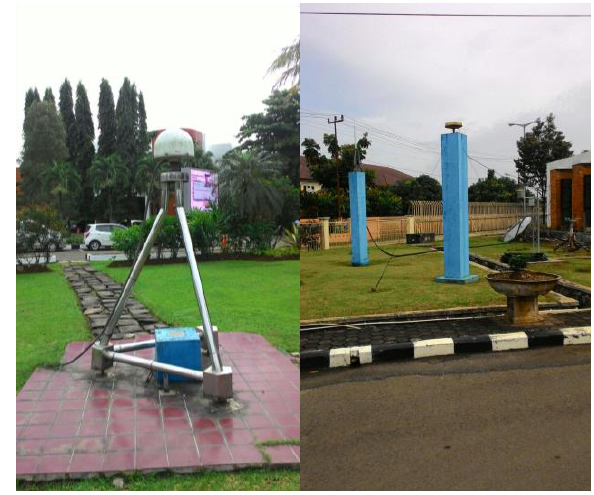
Figure 5. Geodetic Control (CORS) in BIG’s